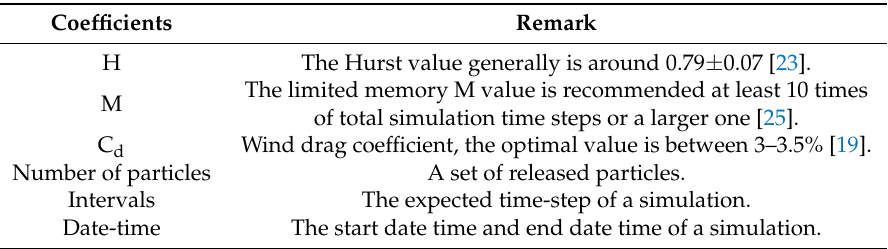
Table 1. Description of the model coefficients.